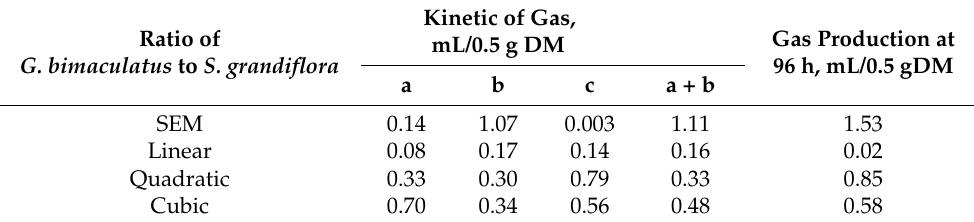
Table 4. Effect of manipulation of in vitro protein degradation from G. bimaculatus powder combined with phytonutrients from S. grandiflora on in vitro dry matter and organic matter digestibility.